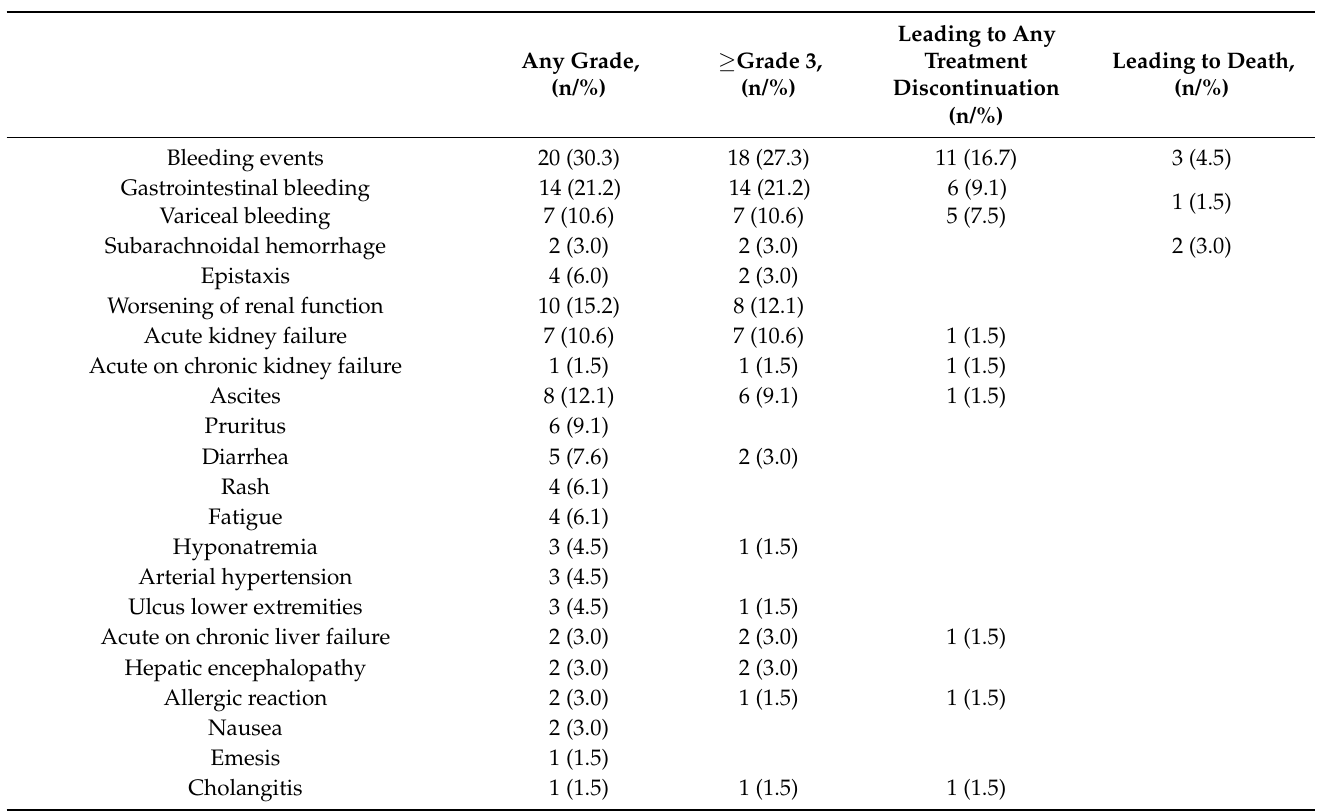
Table 3. Documented adverse